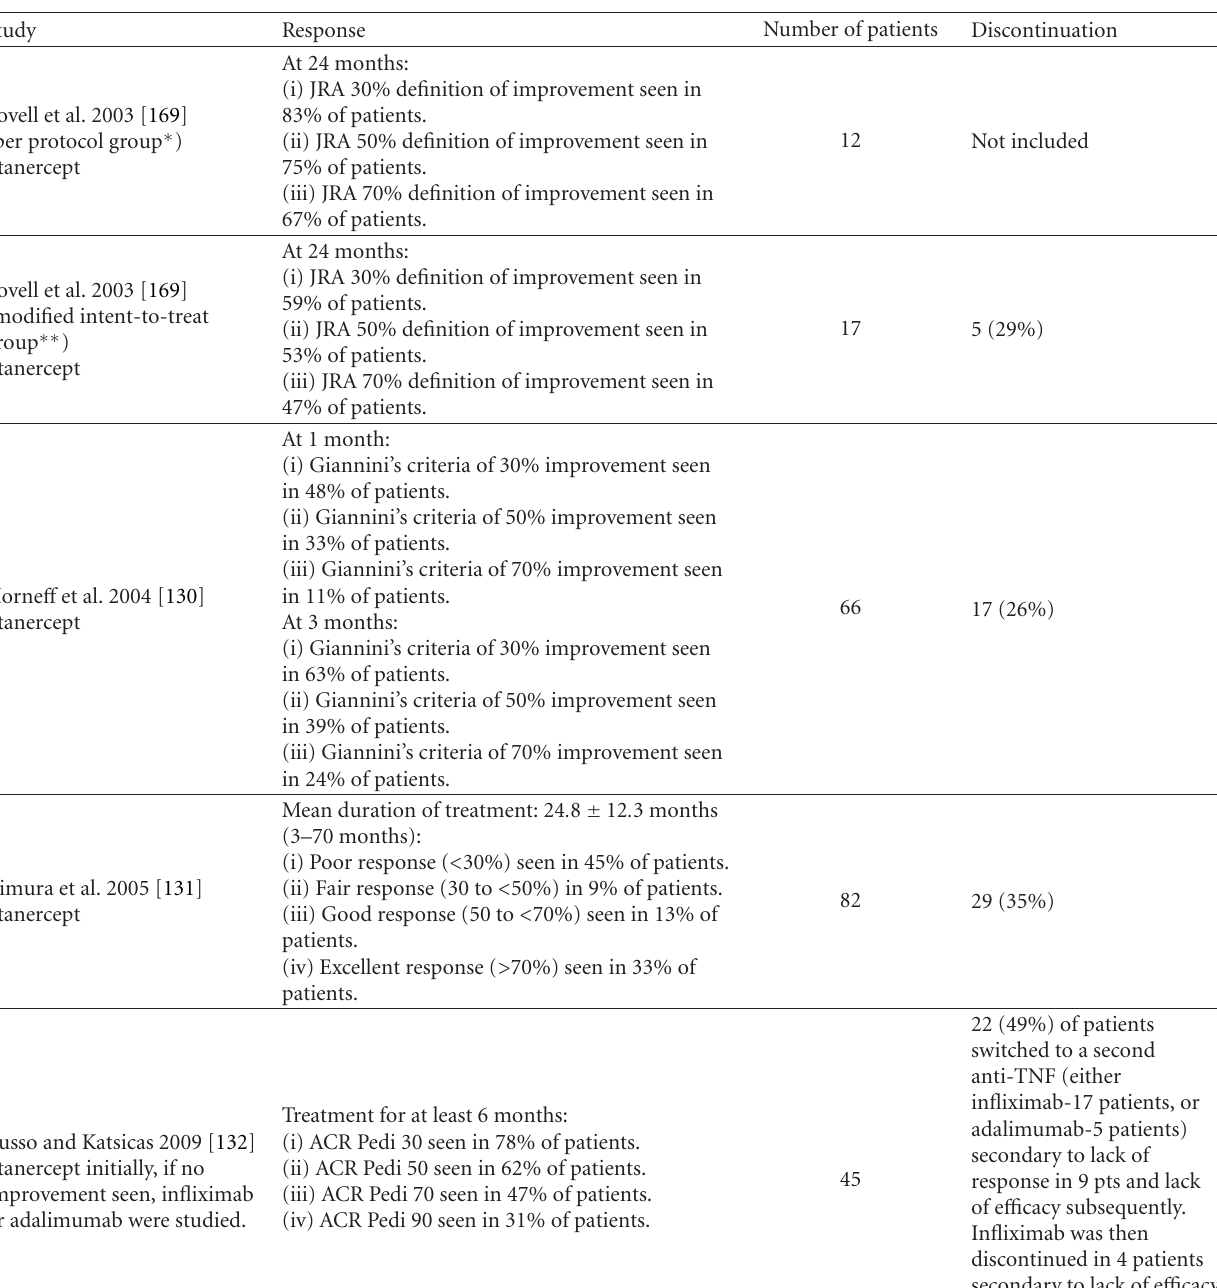
Table 2: Response to anti-TNF therapy in sJIA